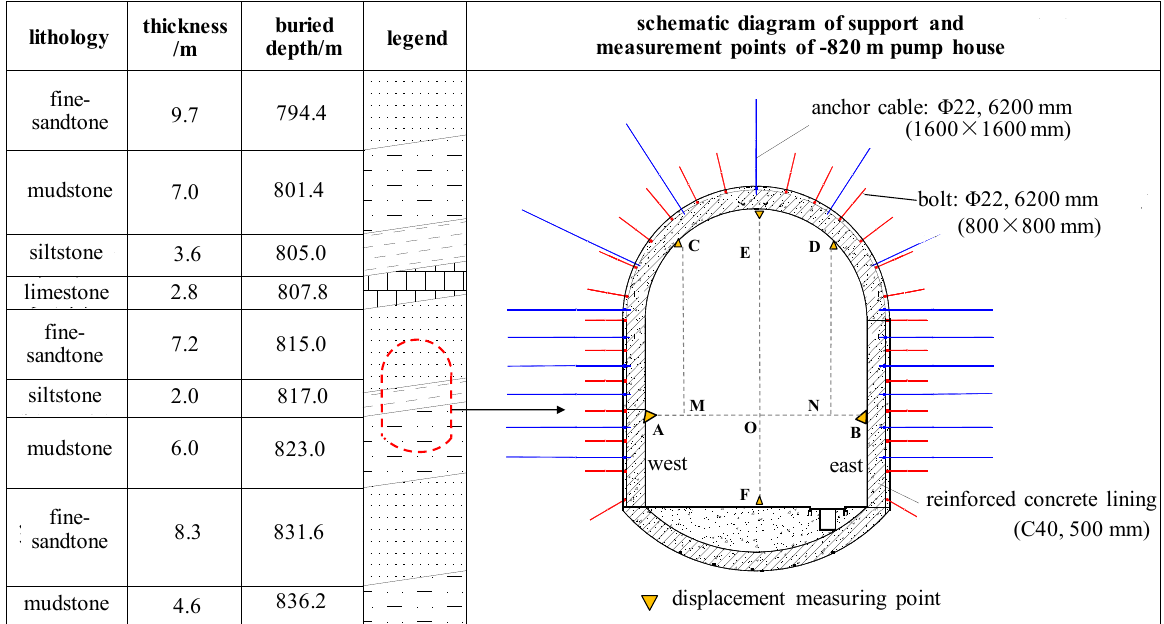
Figure 1. Mine location and − 820 m shaft station plan.